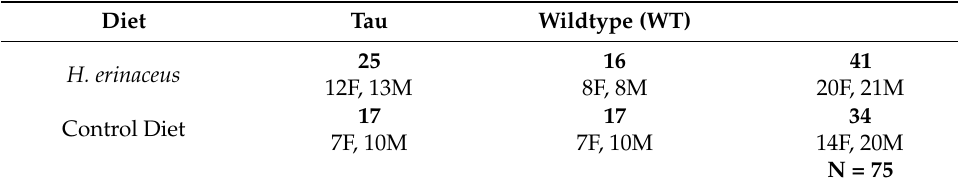
Table 1. Experimental Sample Sizes (Behavioral